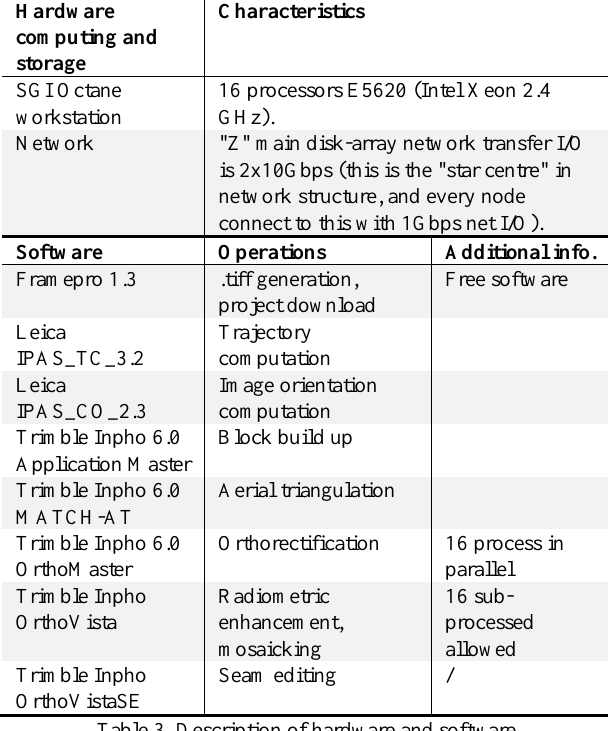
Table 3. Description of hardware and